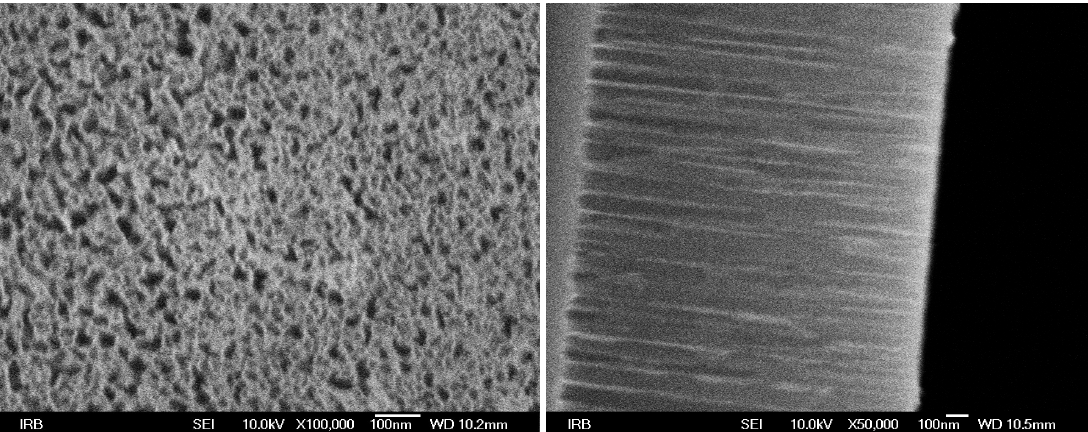
Figure 2. ( Left ) Scanning electron microscope (SEM) image of a sample after etching. ( Right ) Cross- sectional view of a sample showing the ∼ 1.6 µ m thick porous layer on bulk silicon wafer. For details see Section